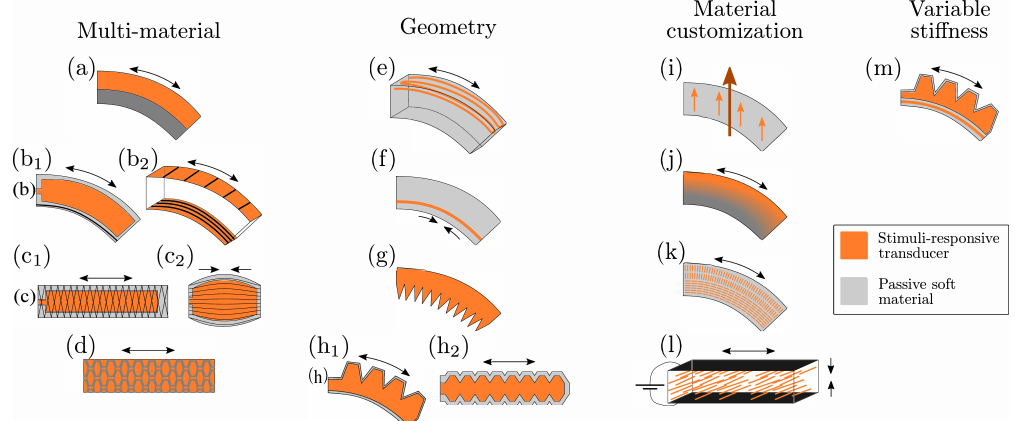
Figure 7. Typical examples of the different types of extrinsic asymmetry: most of the actuators are combinations of the nonexhaustive list of principles illustrated here. ( a ) Bilayer, ( b ) limiting fibre/layer: ( b 1 ) acting as neutral fibre or ( b 2 ) forming a pattern, ( c ) reinforcement: ( c 1 ) fibre reinforcement and ( c 2 ) McKibben muscles, ( d ) Kirigami reinforcement, ( e ) expansive/contractive pattern, ( f ) eccentric actuation, ( g ) swelling rate gradient, ( h ) bellows: ( h 1 ) asymmetrical or ( h 2 ) symmetrical, ( i ) magnetization profile, ( j ) gradient, ( k ) local fibre alignment, ( l ) anisotropic stiffness and ( m ) stiffness